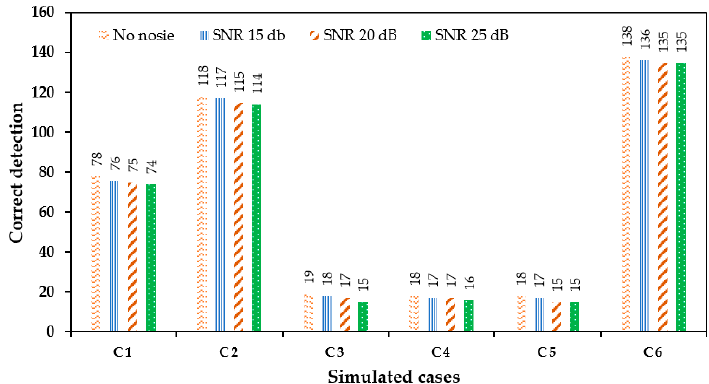
Figure 18. The correct detection of the proposed algorithm under ideal and noisy conditions.